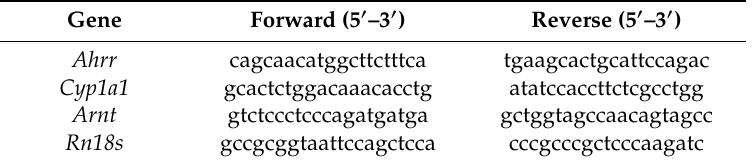
Table 3. Quantitative real-time polymerase chain reaction primers sequences.